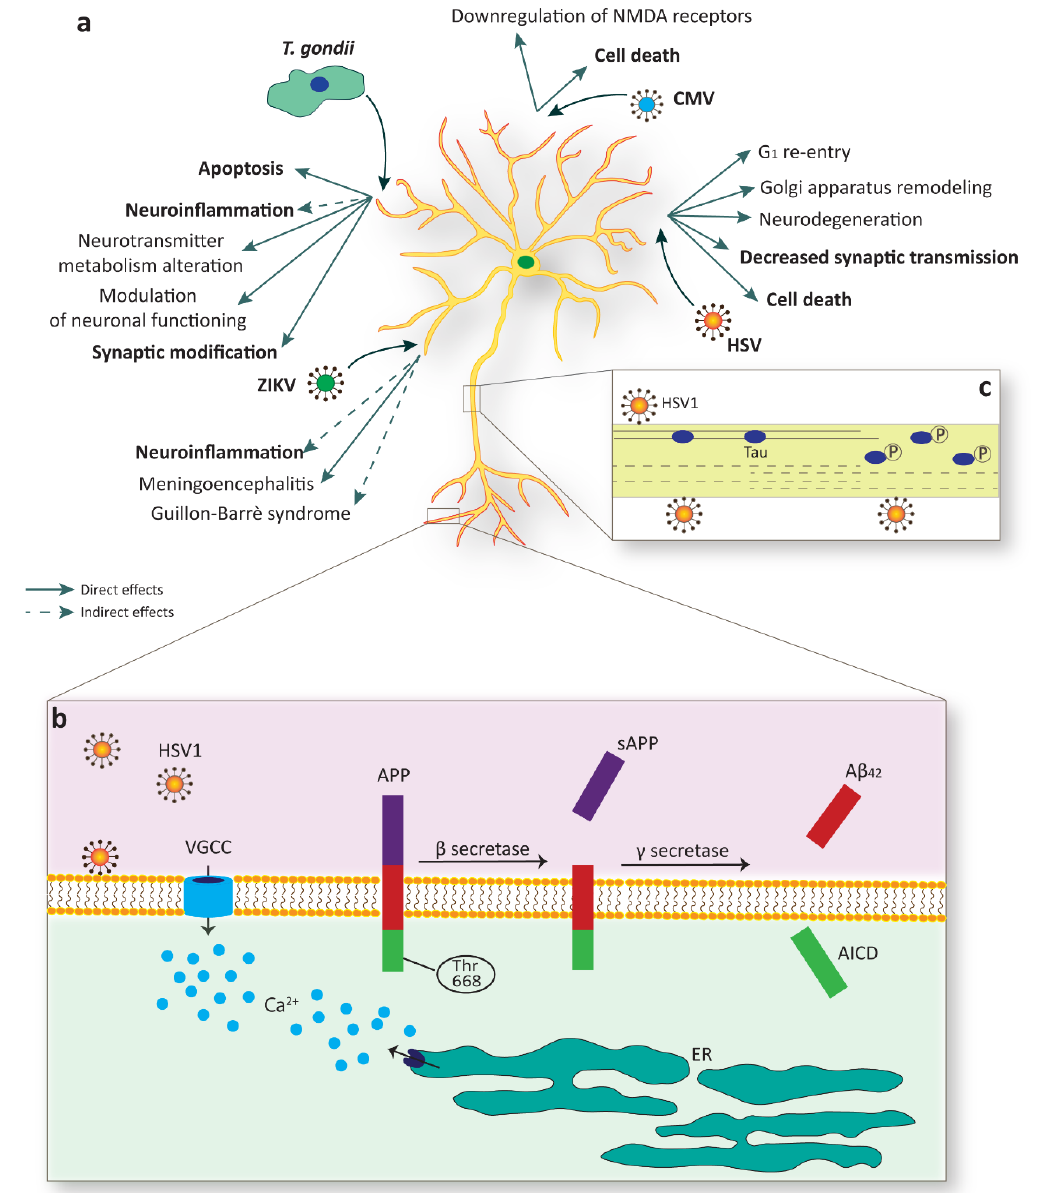
Figure 3. Mature neurons are a target of specific TORCH agents. ( a ) Multiple infections sustained by different pathogens, such as Zika virus (ZIKV), Toxoplasma gondii ( T. gondii ), cytomegalovirus (CMV), and Herpes simplex virus (HSV), evoke detrimental effects in mature neurons, including cell death or substantial alterations in function. ( b ) HSV-1 infection sustains membrane depolarization with the consequent increase in intracellular calcium via voltage-gated calcium channels (VGCC) or through depletion from intracellular stores, such as the endoplasmic reticulum (ER). HSV-1 infection is also linked to amyloid precursor protein (APP) phosphorylation of Thr668 which facilitates the amyloidogenic APP cleavage by BACE1 (as known as β secretase) and the release of Aβ 42 . AICD, APP intracellular domain. ( c ) A paradigmatic example of structural alteration due to viral infection is linked to the phosphorylation of the microtubule-associated protein MAPT (as known as Tau). Tau phosphorylation upon HSV-1 infection produces its release from microtubules with consequential loss in stability.